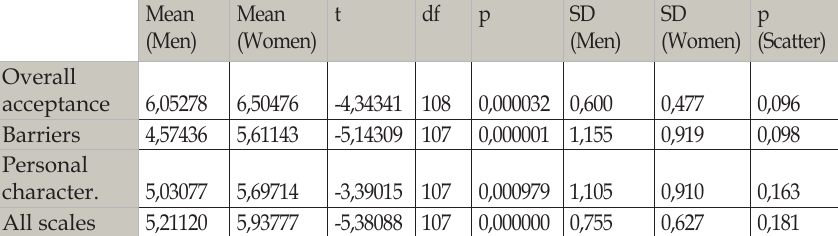
Table 4: Gender stereotypes according to gender of